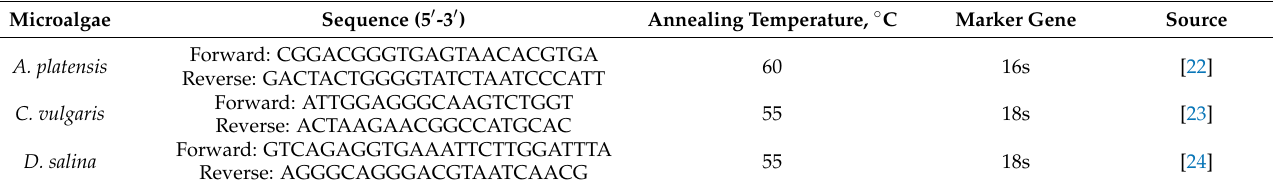
Table 1. Microalgae primer